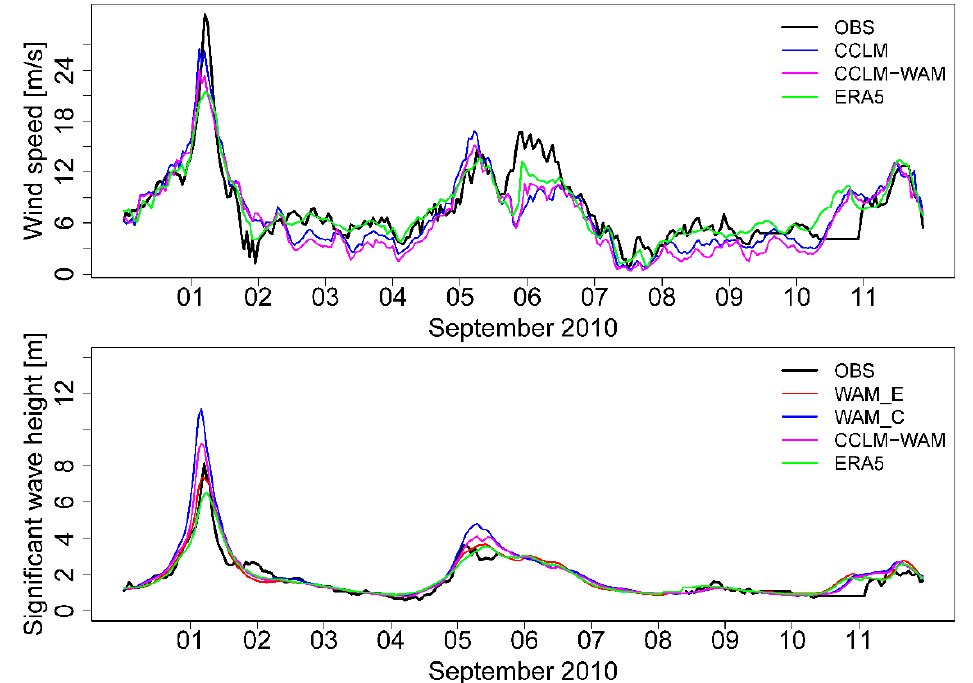
Figure 10. Wind speed and significant wave heights during three typhoon events at station IEODO.